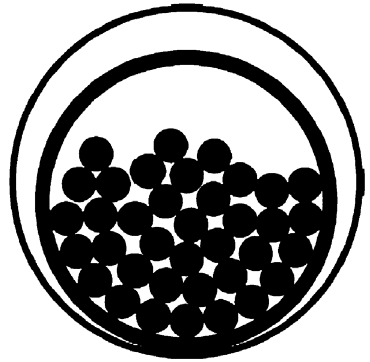
Fig. 3. Flow rerouting due to bundle collapse